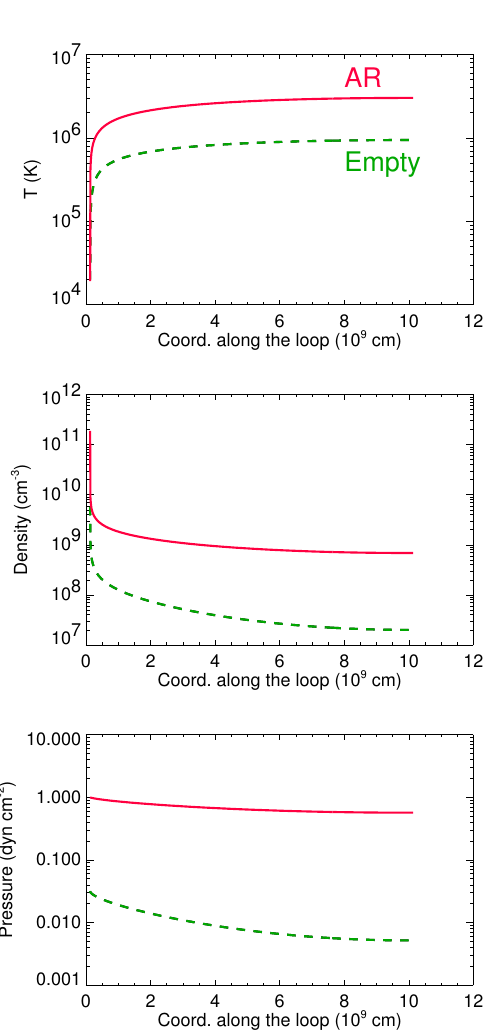
Figure 14: Distributions of temperature, density, and pressure along a hydrostatic loop computed from the model of Serio et al. (1981) for a high pressure loop (AR) and a low pressure one (Empty) with heating uniformly distributed along the